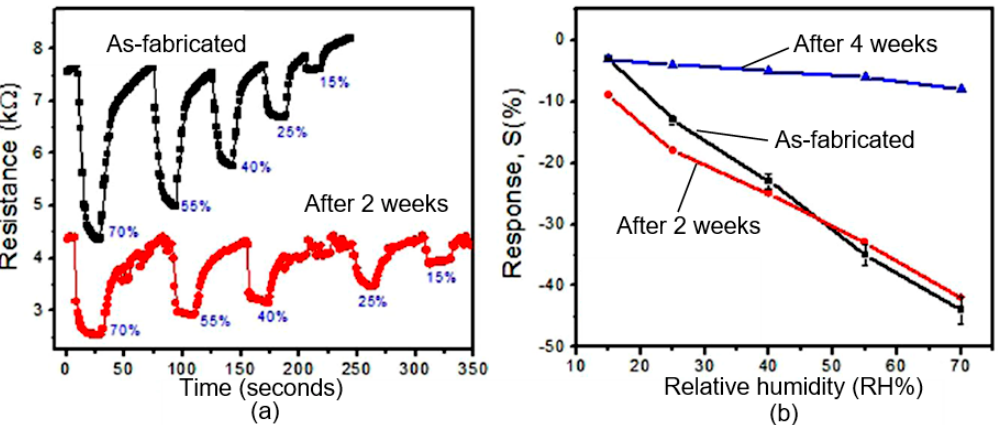
Figure 22. ( a ) Transient response of the BP/graphene humidity sensor as-fabricated and after 2 weeks. ( b ) Aging influence on sensor response of BP/graphene humidity sensor. Reproduced from Ref.